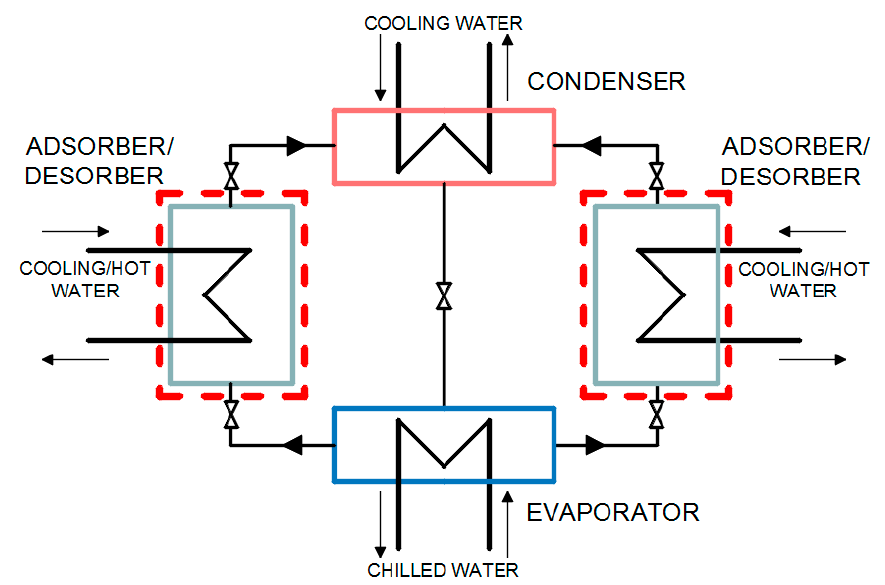
Figure 1. Configuration of the adsorption heat pump under consideration.